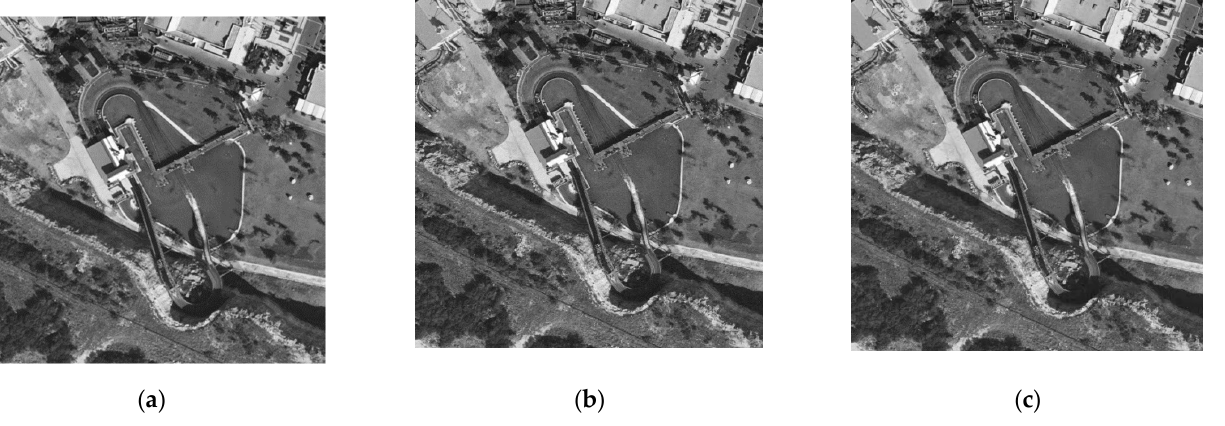
Figure 13. The scatter-plot ∆𝑃𝑆𝑁𝑅 − 𝐻𝑉𝑆 − 𝑀 vs. 𝑃 2𝜎 and the fitted curve (the weighted sum of two exponentials, RMSE is about 1.64 and the R 2 and AdjR 2 are about 0.87).